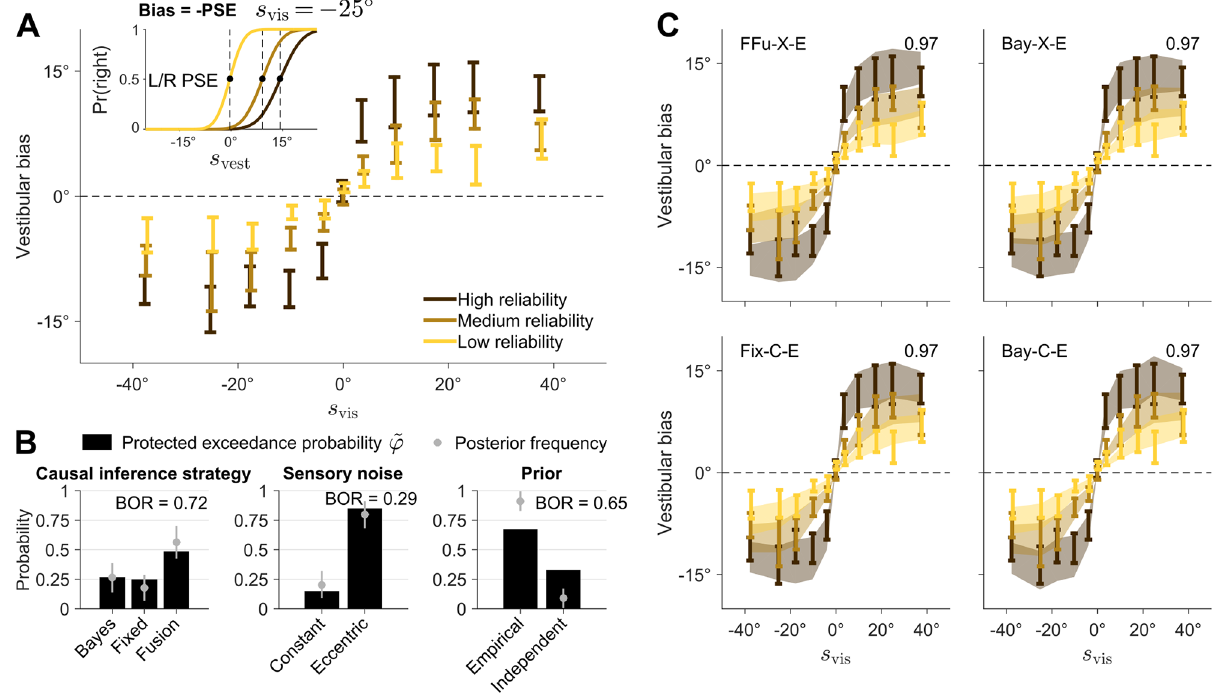
Fig 4. Implicit causal inference. Results of the implicit causal inference (left/right inertial discrimination) task. A : Vestibular bias as a function of co- presented visual heading direction s vis , at different levels of visual reliability. Bars are ±1 SEM across subjects. The inset shows a cartoon of how the vestibular bias is computed as minus the point of subjective equality of the psychometric curves of left/right responses (L/R PSE) for vestibular stimuli s vest , for a representative subject and for a fixed value of s vis . The vestibular bias is strongly modulated by s vis and its reliability. B : Protected exceedance probability ~ φ and estimated posterior frequency (mean ± SD) of distinct model components for each model factor. Each factor also displays the Bayesian omnibus risk (BOR). C : Model fits of several models of interests (see text for details). Shaded areas are ±1 SEM of model predictions across subjects. Numbers on top right of each panel report the absolute goodness of fit.